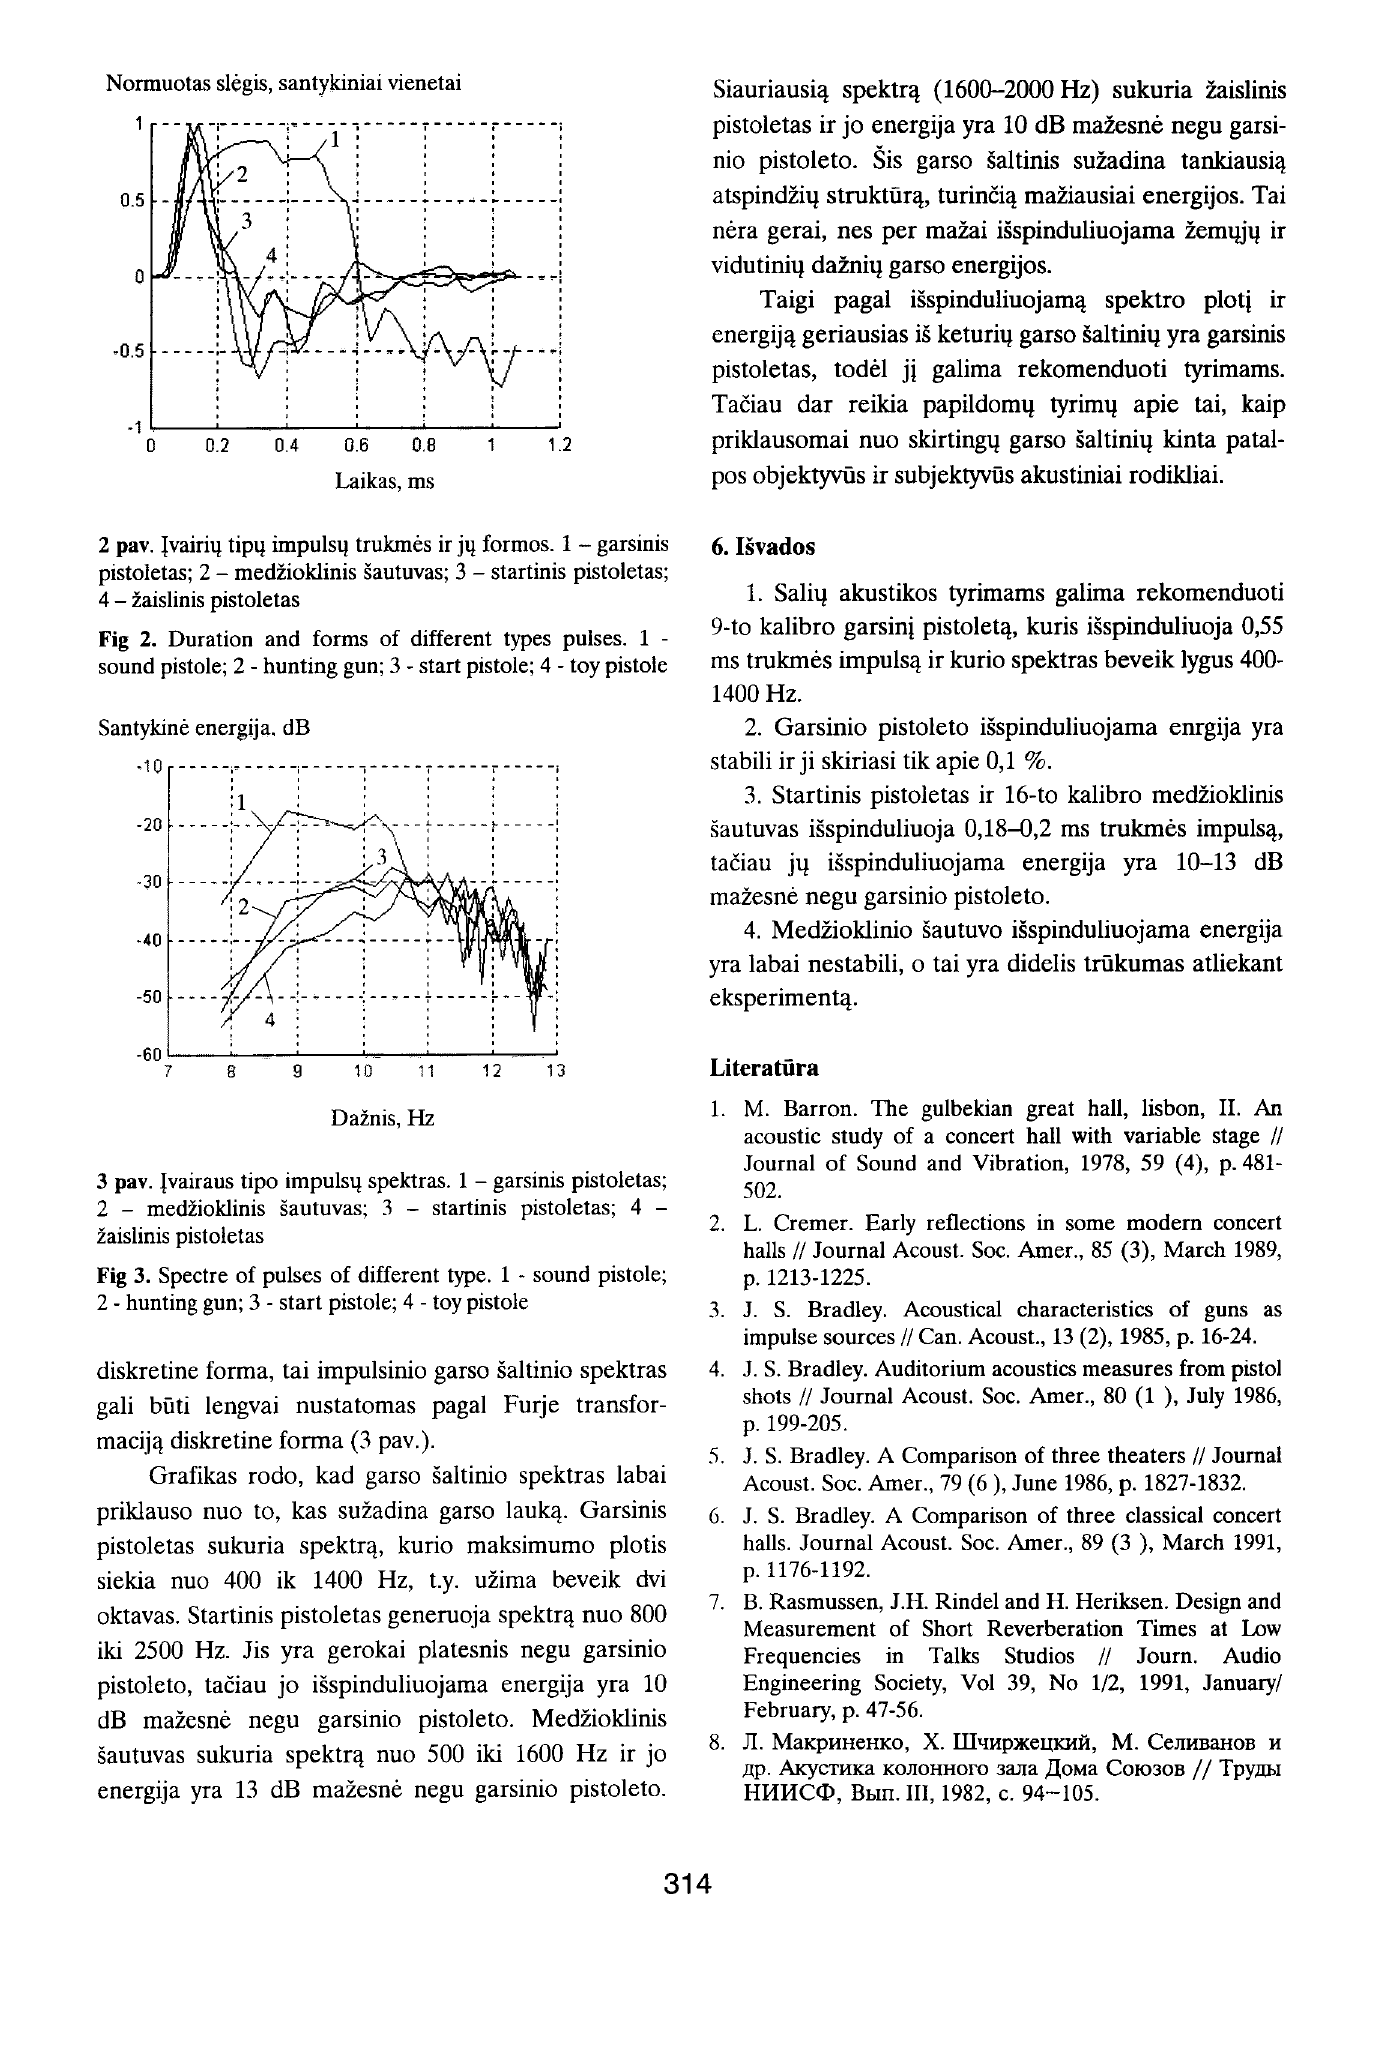
2 pav. lvairiq tipq impulsq trukmes ir jq formos. 1 - garsinis pistoletas; 2 - medzioklinis sautuvas; 3 - startinis pistoletas; Fig 2. Duration and forms of different types pulses. 1 - sound pistole; 2 - hunting gun; 3 - start pistole; 4 - toy pistole Santykine energija. dB